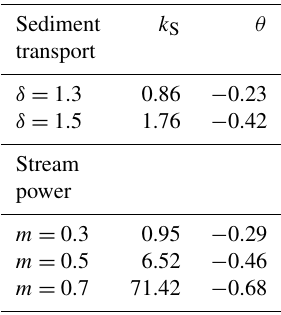
Table 1. Slope–area relationship for trunk streams derived using χ analysis (Perron and Royden,